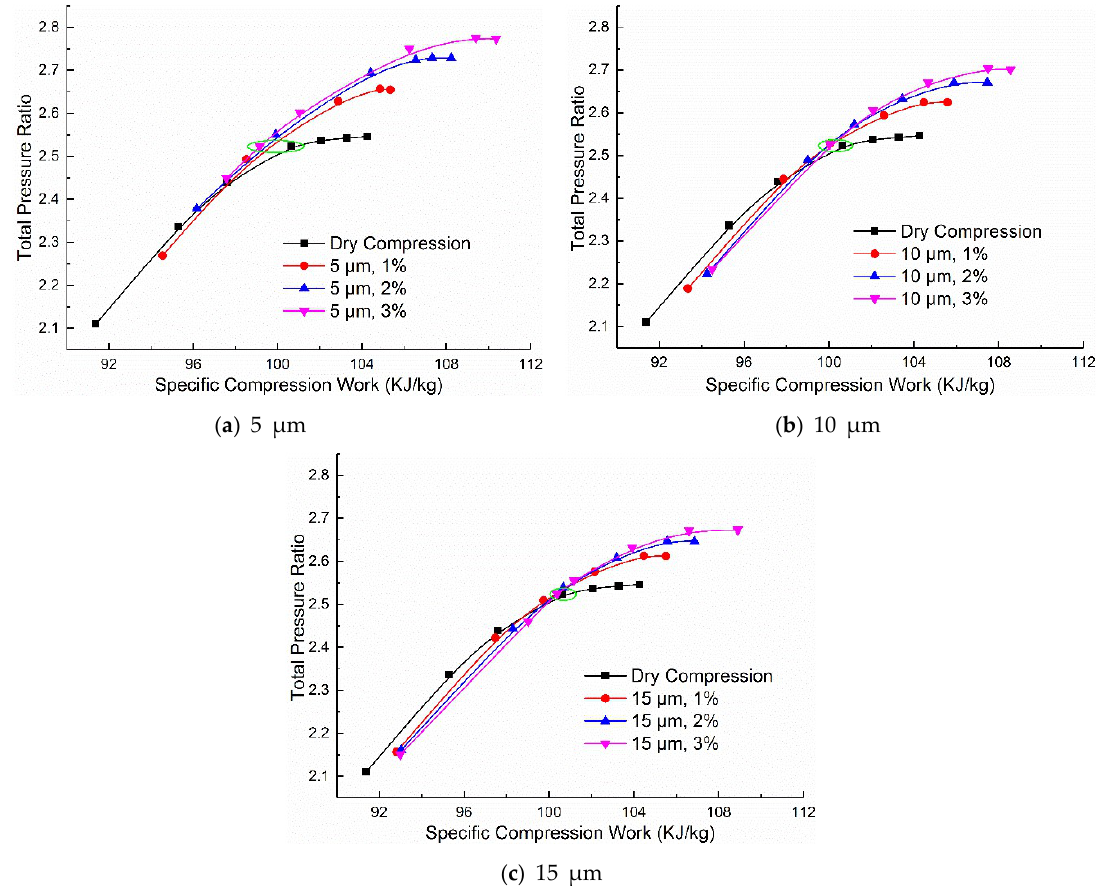
Figure 8. Comparison of the specific compression work between dry and wet compression